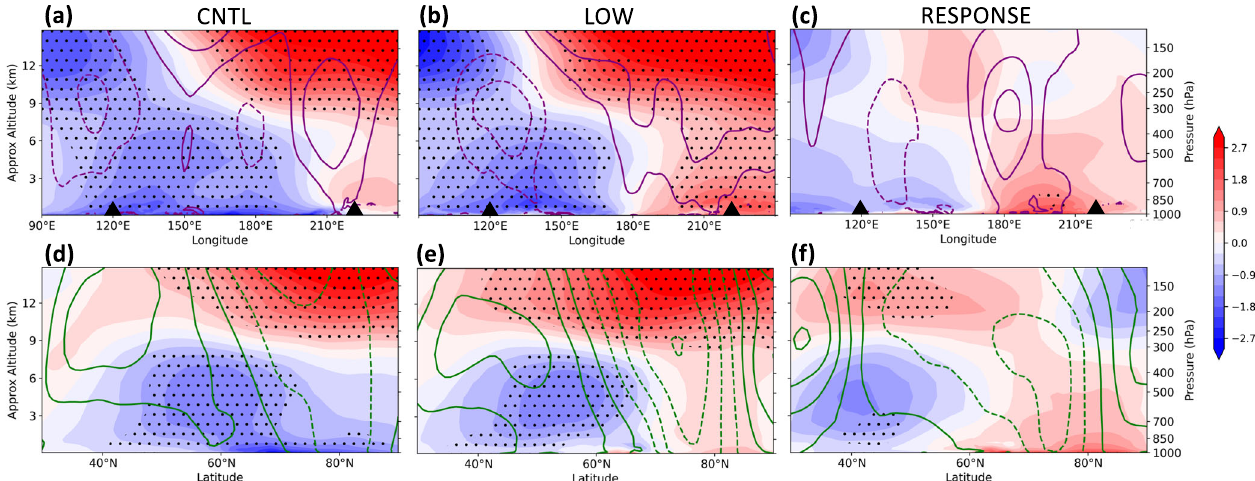
Fig. 7 Composite temperature (T), zonal wind (U), and meridional wind (V) prior to SSW (averaged between day − 10 to day − 1). Longitude-altitude cross-section of T and V anomaly in CNTL ( a ), LOW ( b ), and the response ( c ). T (averaged between 60°N – 80°N) is shown as fi lled contours and V at 60°N as line contours (every 1 m s − 1 interval). The black triangles mark the longitudinal edges of the sea ice loss region. Corresponding latitude-altitude cross-sections of T and U anomaly (averaged over 150°E – 210°E) are given in ( d – f ). Stippling indicates T statistical signi fi cance at the 95%